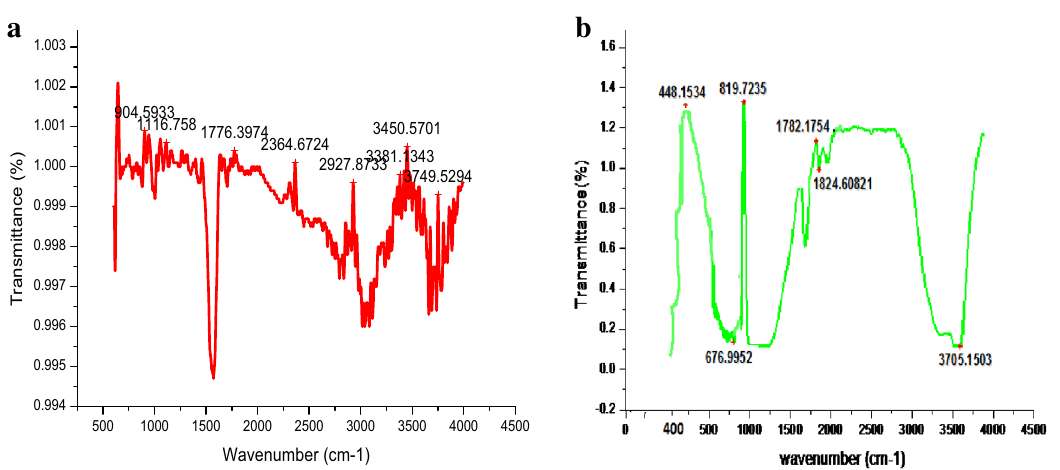
Figure 10. ( a) FT-IR spectra of carbon sphere before loading Zn. ( b ) FT-IR spectra of carbon sphere after loading